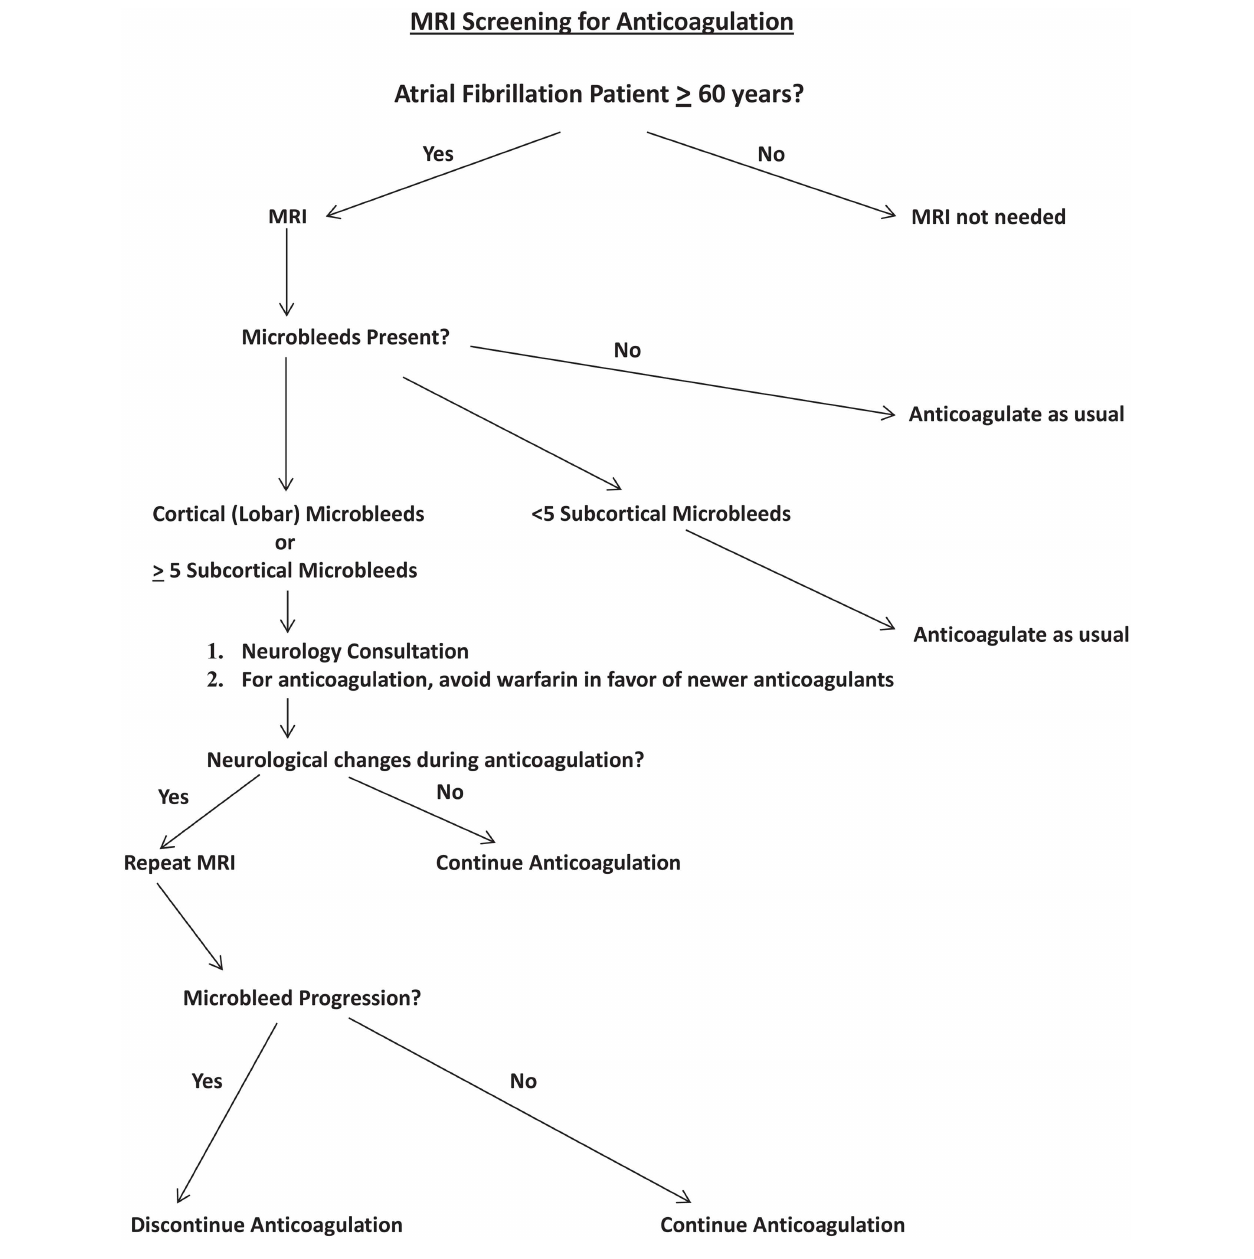
FIGURE 1 | Proposed algorithm for incorporation of MRI screening into decision-making for anticoagulation for atrial fibrillation patients . “Newer anticoagulants” refers to agents such as dabigatran and rivaroxaban.